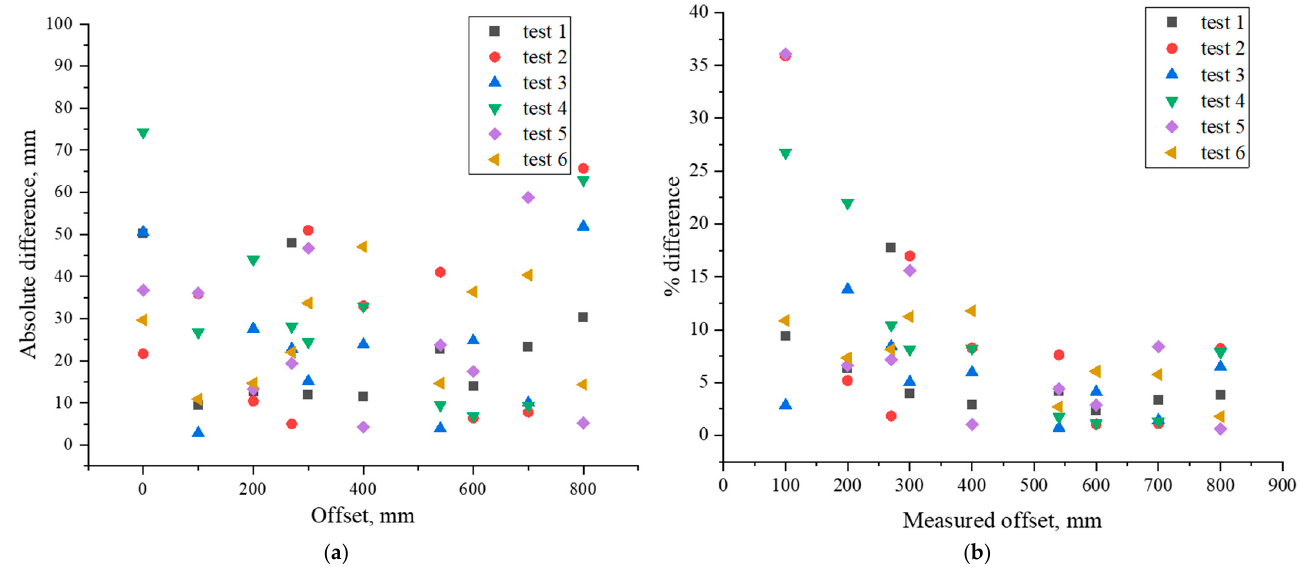
Figure 5. Calculated offset vs. measured offset.